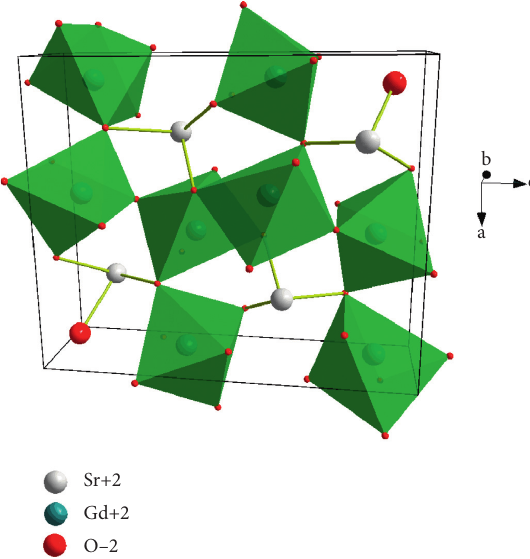
Figure 1: The cell structure of SrGd